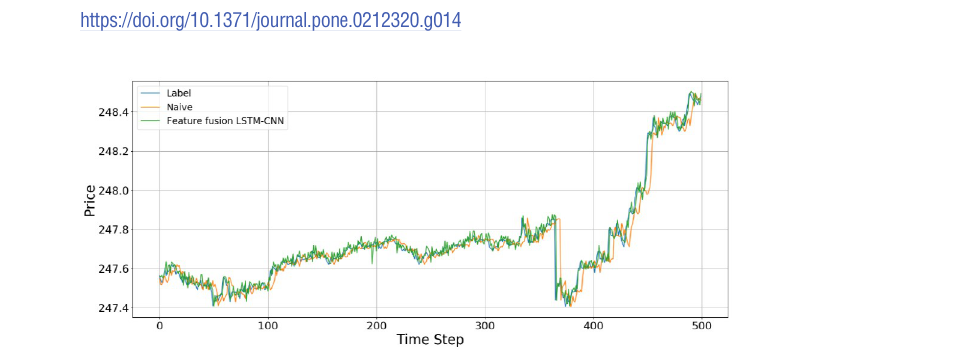
Fig 14. An example of predicting stock prices using the feature fusion LSTM-CNN model and Naive model on the testing dataset. The input data are candlebar chart and stock time series.